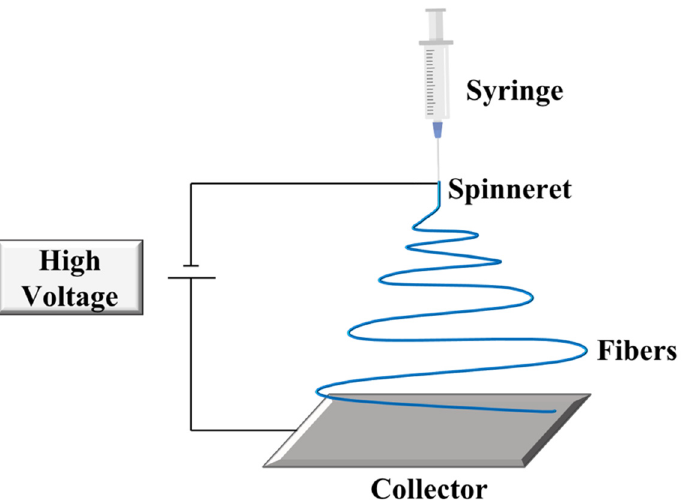
Figure 5. Schematic representation of an electrospinning setup.